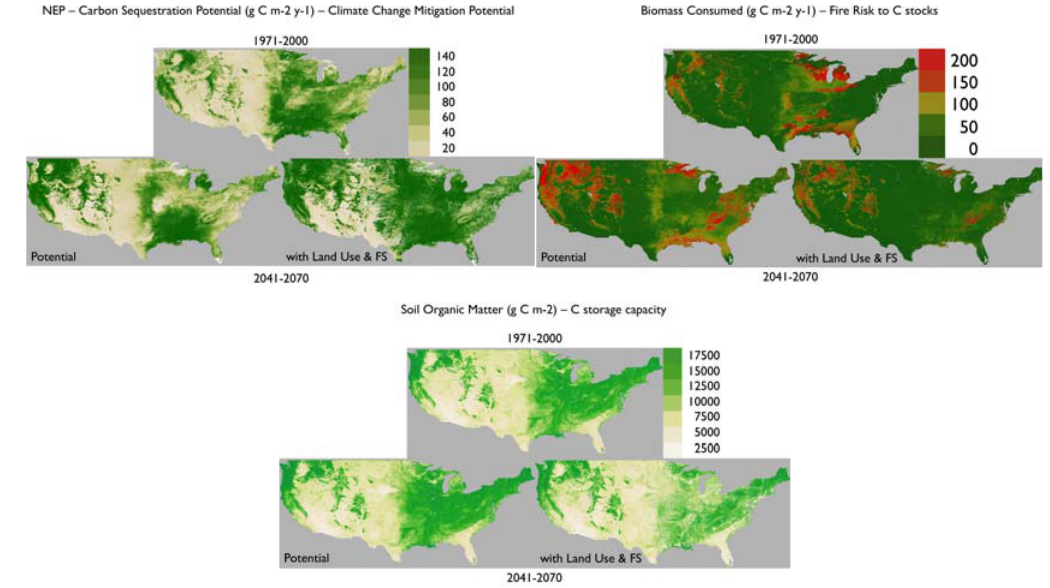
Figure 2. Simulated net ecosystem production (NEP), biomass consumed by wildfires and soil carbon for historical conditions (1971–2000) and for future conditions across 3 possible futures (climate projections from CGCM3, MIROC and CSIRO) under the A2 emission scenario (2041–2070). We show simulation results at 30 arcsec spatial resolution for mid-century with and without land use and fire suppression.